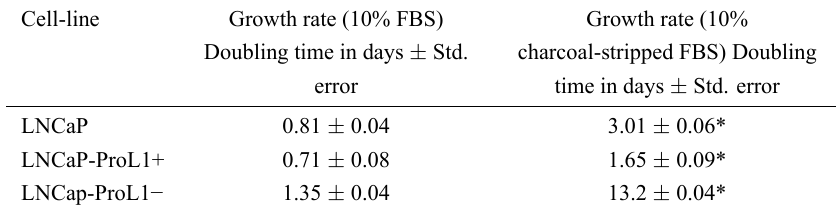
Table 1. Growth characteristics of the cell-lines used in these